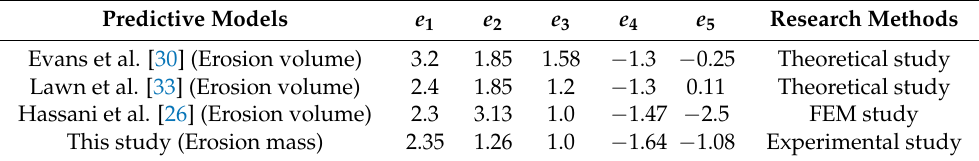
Table 2. Comparison of the exponents in different erosion predictive models for brittle